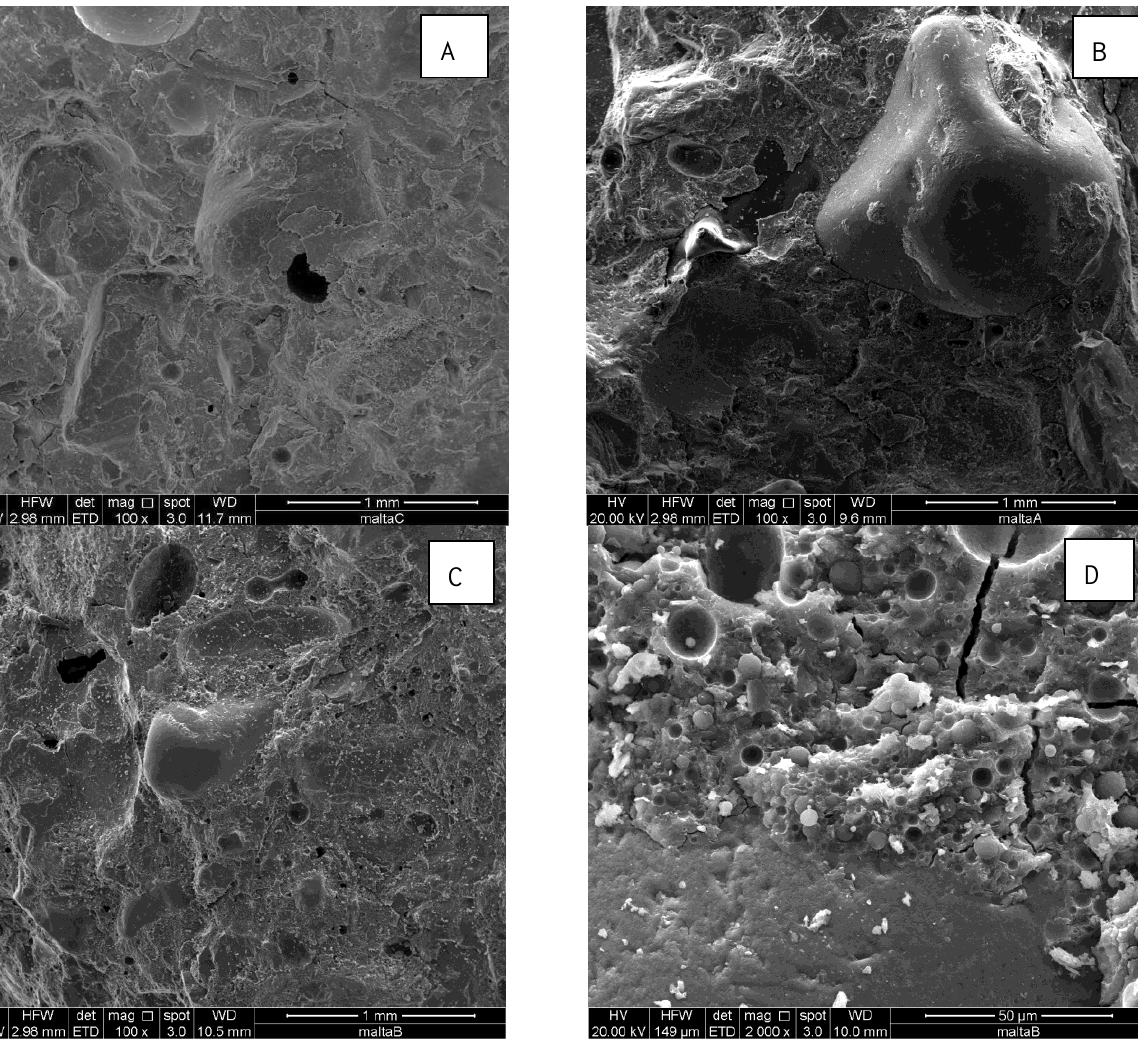
Figure 2. SEM micrographs of the neat geopolymer mortar ( A ) G66; ( B ) E66; and ( C , D )